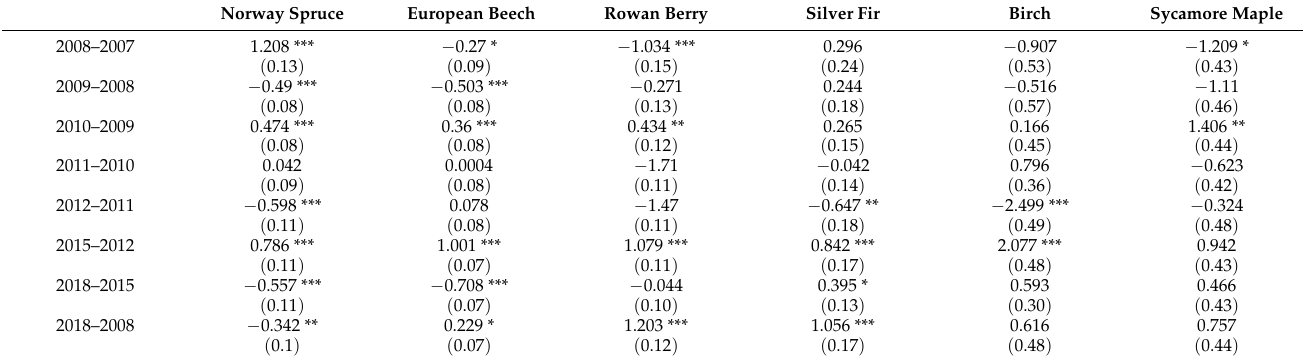
Table A2. Summary statistics of the multiple comparisons of means between year levels for the respective tree species. Next to each categorical time step, logarithmic coefficients and the standard error (in parentheses) can be